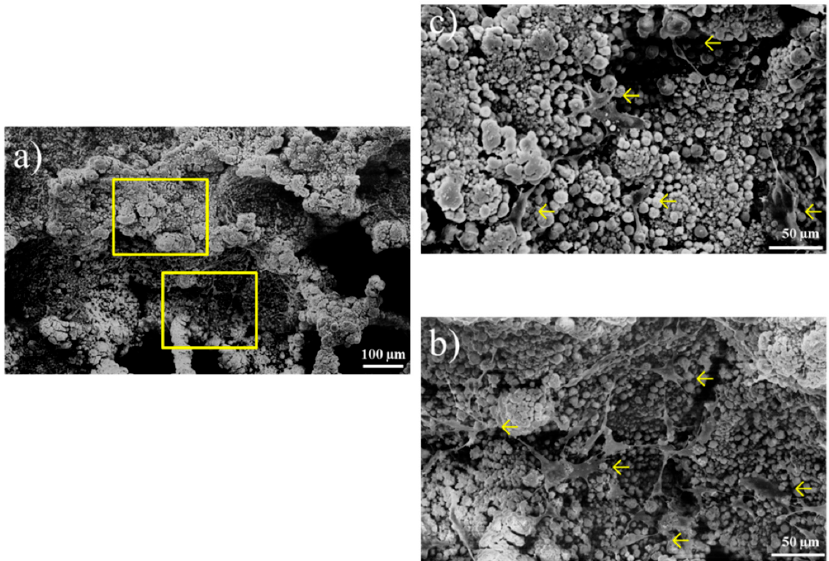
Figure 10. ( a ) Cell attached to porous Ti ‐ AT ‐ SPT after 4h incubation. ( b ) Cell attached at the outer surface of concavity in the porous structure. ( c ) Cell attached at the inner surface of concavity in the porous structure. SEM images of the cells attached to Porous Ti ‐ AT ‐ SPT after 4 h incubation. The attached cells indicated by arrows were located not only on the outer surface (upper yellow square represents c) but also on the surface of concavity (lower square represents b)